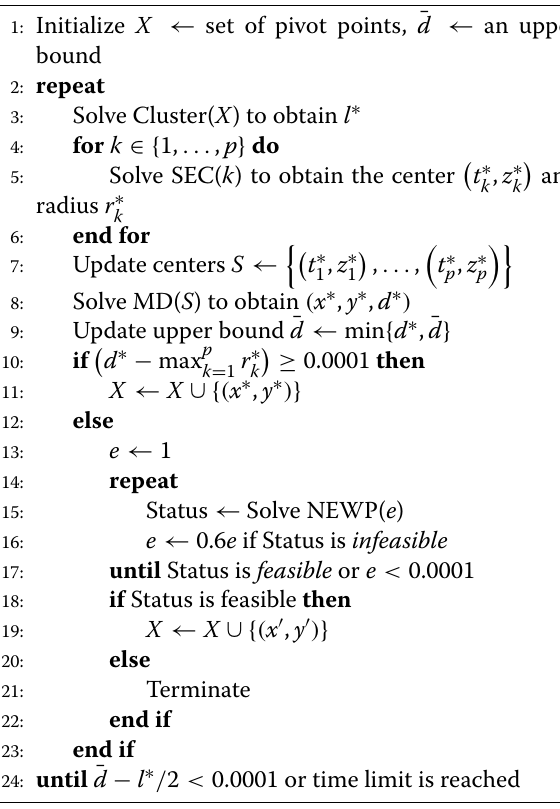
Algorithm 2 Clustering-based method for lower bound- ing the p -center